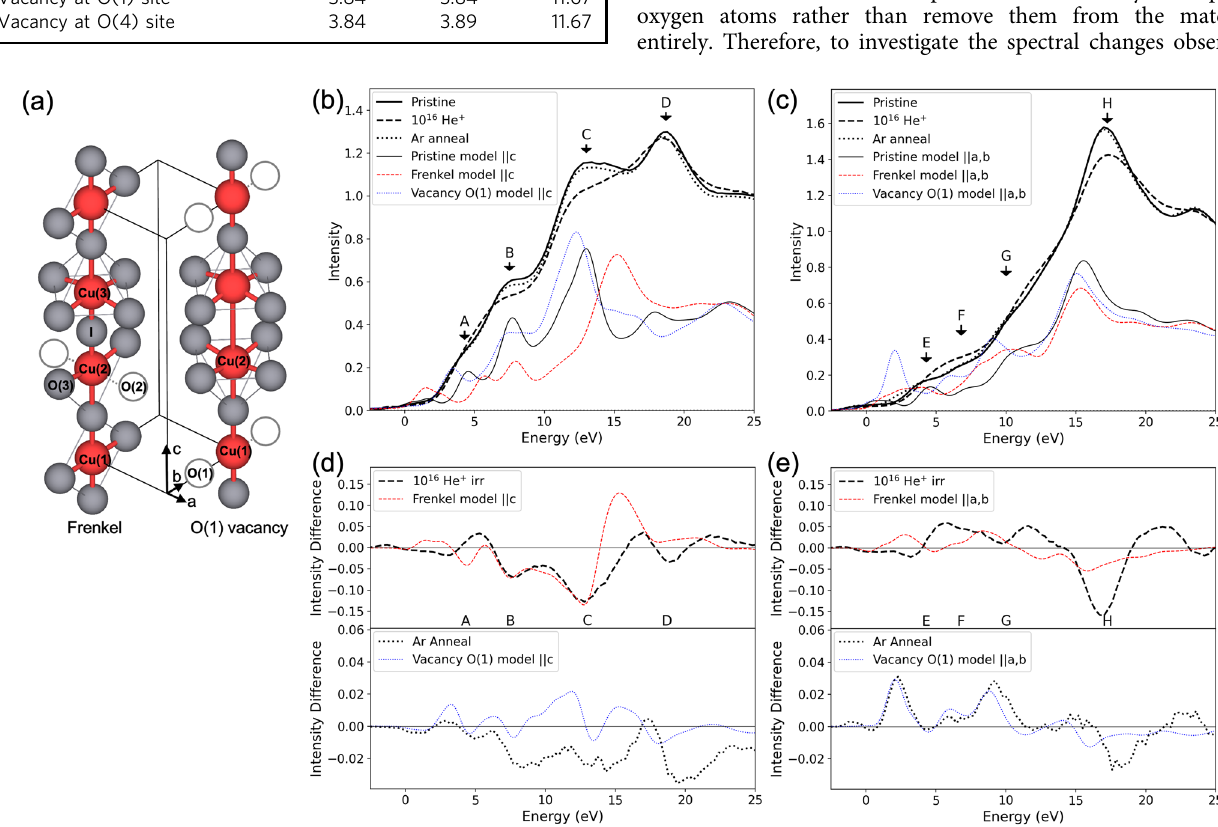
Fig. 6 Comparison of XANES spectra with DFT calculated spectra from selected defect models. a Schematic diagrams showing the Frenkel and O(1) vacancy defects. Comparison of the pristine, 10 16 He + irradiated and Ar annealed samples with the pristine, Frenkel and O(1) vacancy defect models for YBCO, for b ^ E ∣∣ c and c ^ E ∣∣ a / b with the ^ E ∣∣ a / b modelled spectra being the average of the a and b spectra. d , e Show the corresponding difference spectra with the experimental He + irradiated and Ar annealed spectra shown relative to the experimental pristine spectra, and the Frenkel and O(1) vacancy models shown relative to the pristine